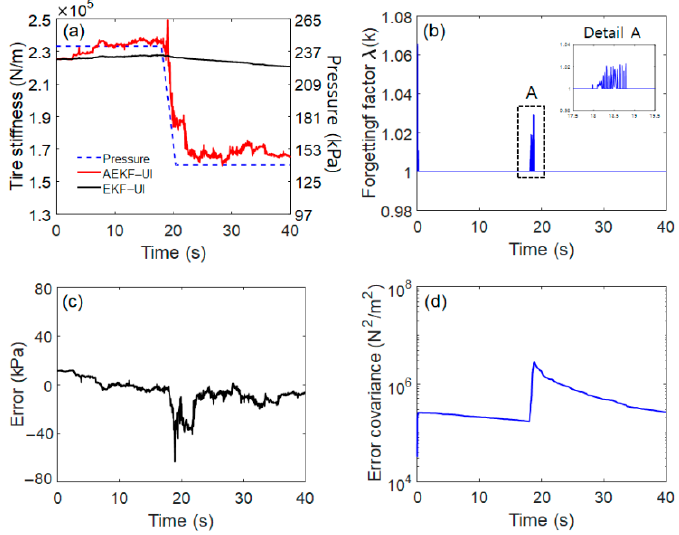
Figure 7. Simulation result of tire stiffness estimation; ( a ) responses of time-varying tire pressure to slew rate limited input (pressure drop), ( b ) time evolution of the forgetting factor (inset, detail around pressure change), ( c ) estimation error (AEKF − UI) and ( d ) convergence history of error covariance.